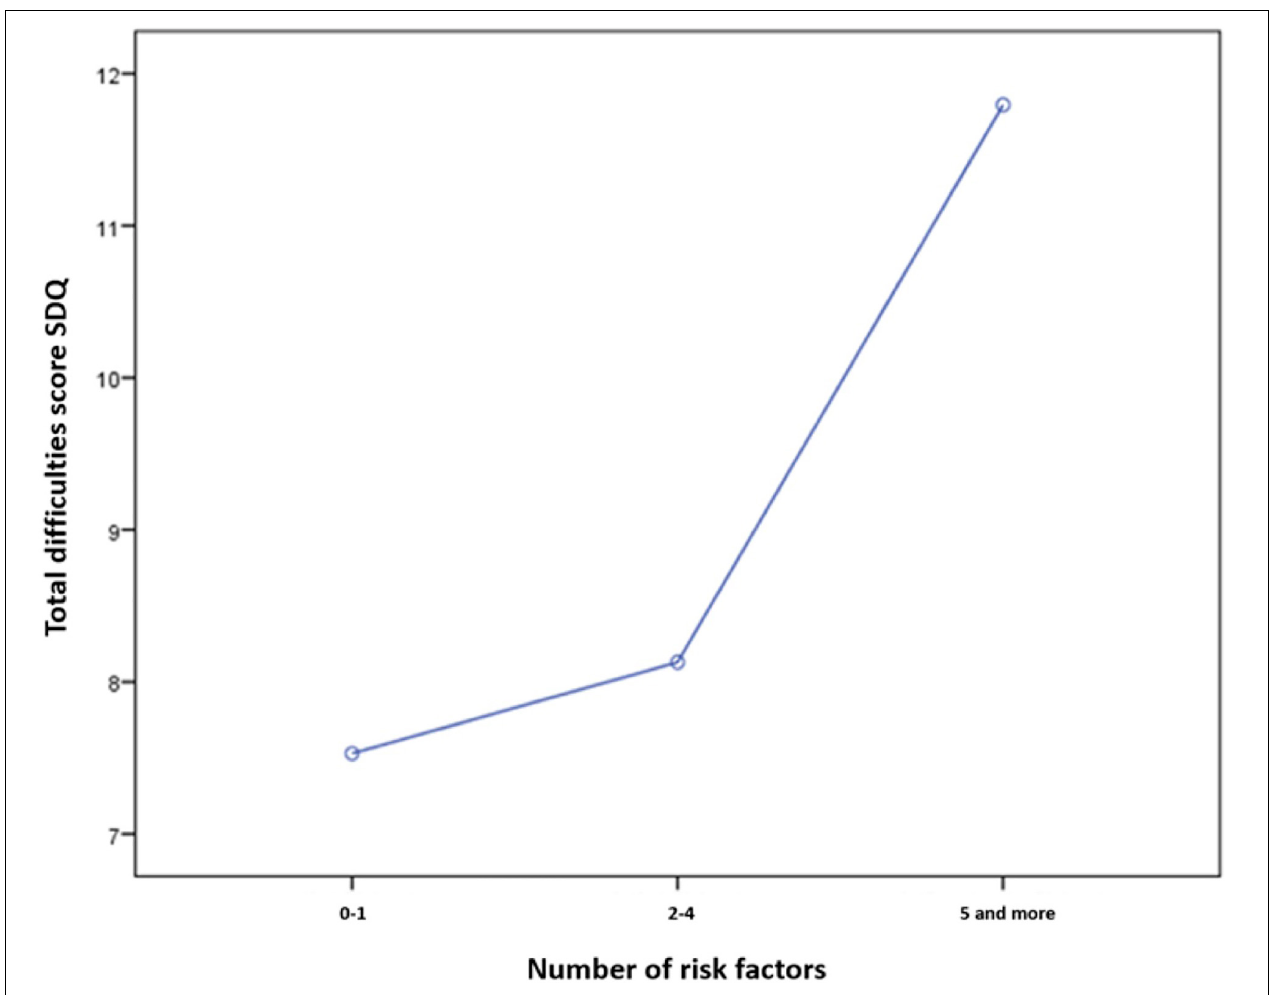
FIGURE 5 | Number of risk factors in relation to total difficulties score of the SDQ.